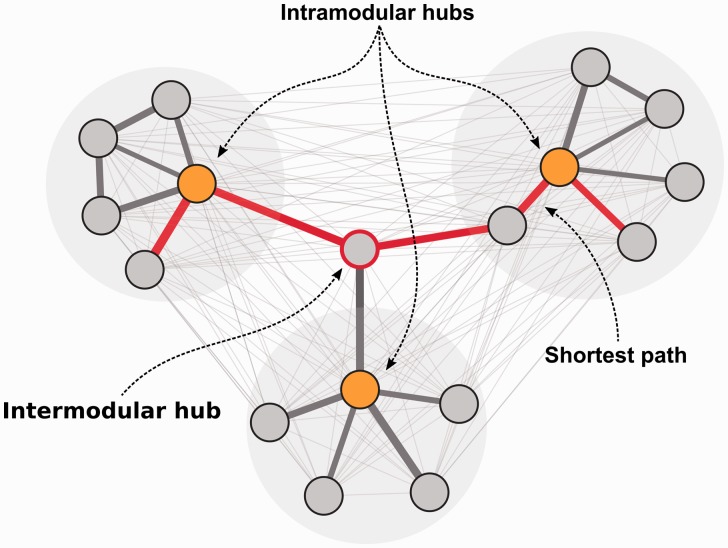
Hypothetical network explaining inter- and intra-modular hubs and network centrality. The inter-modular hub has a high network centrality, as it is required for the largest number of shortest paths between all possible node pairs. The red line indicates an example of a shortest path through the network between a pair of nodes. Intra-modular hubs (marked with orange) are central to individual modules and usually have high biological relevance.